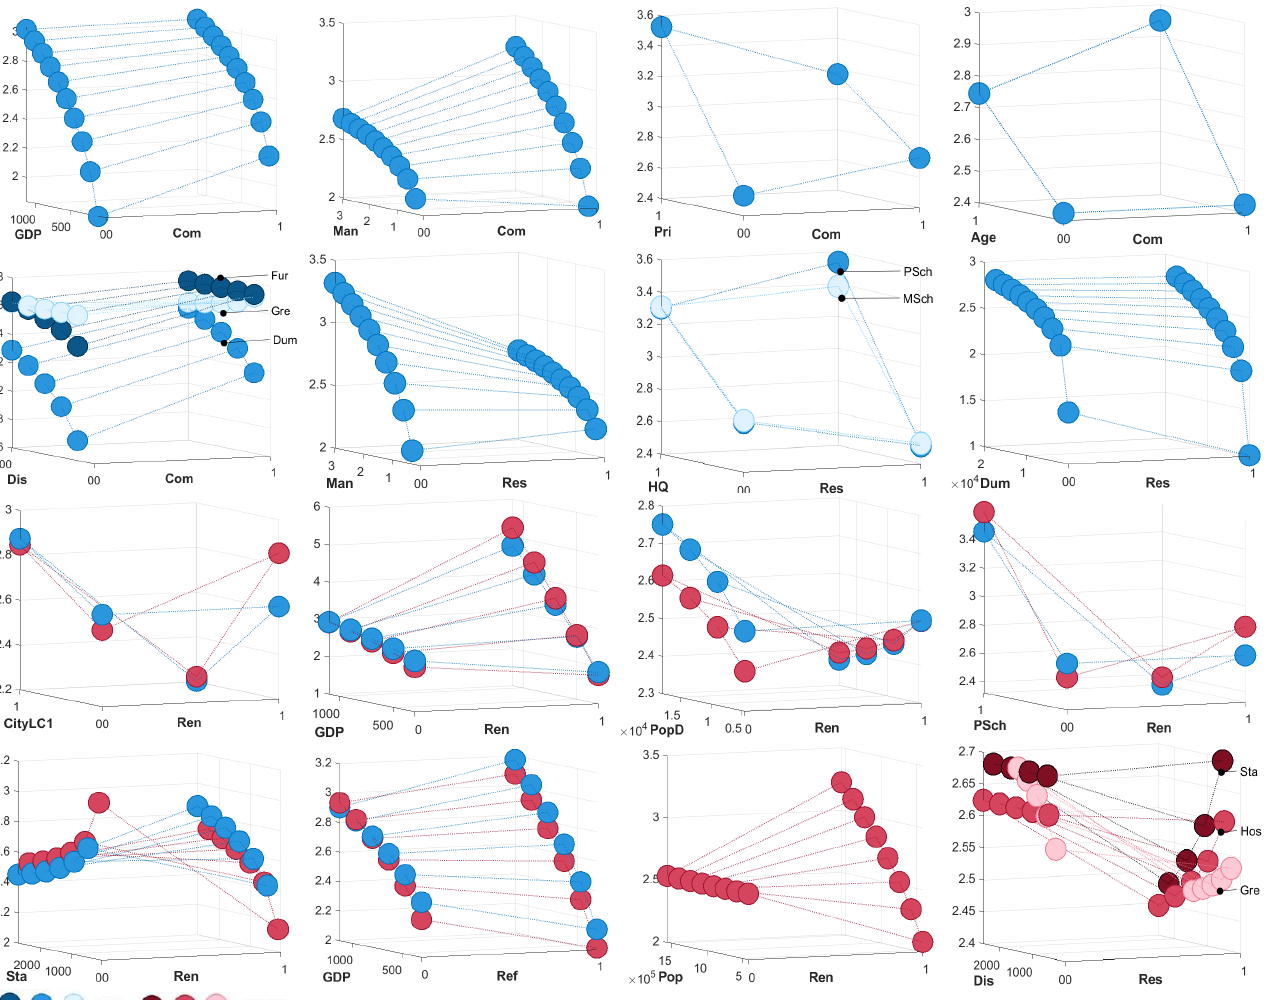
Figure 5. Price model chart of residence types.